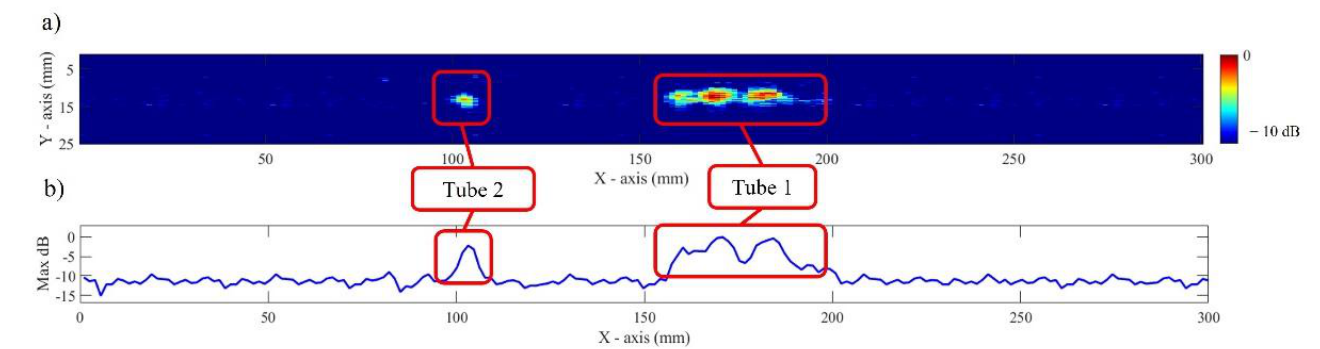
Figure 9. Results showing: ( a ) C-scan obtained from computed TFM frames and ( b ) extracted maximum amplitude along X -axis.